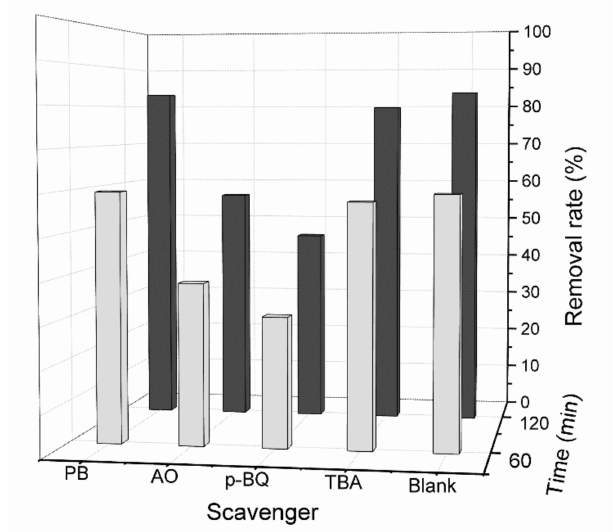
Figure 9. Photocatalytic degradation of MeB by BiOBr/Bi 2 S 3 /CdS in presence of different scavengers.